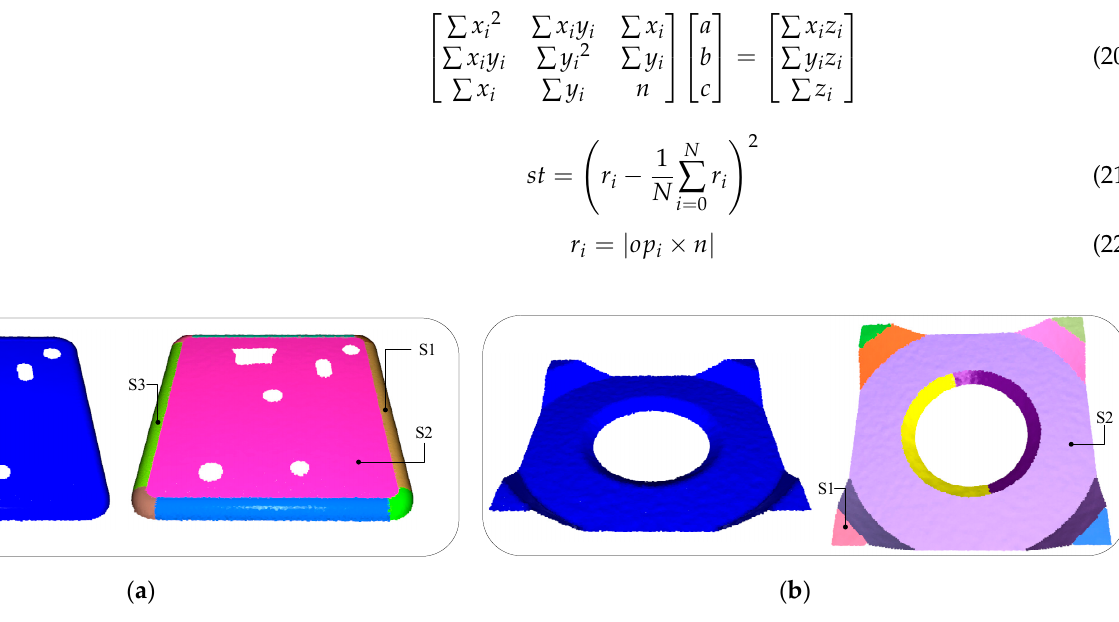
Figure 18. Part measurement point cloud segmentation results and the functional surface to be analysed. ( a ) Functional surfaces of part 1; ( b ) Functional surfaces of part 2. Table 3. Error analysis for workpieces